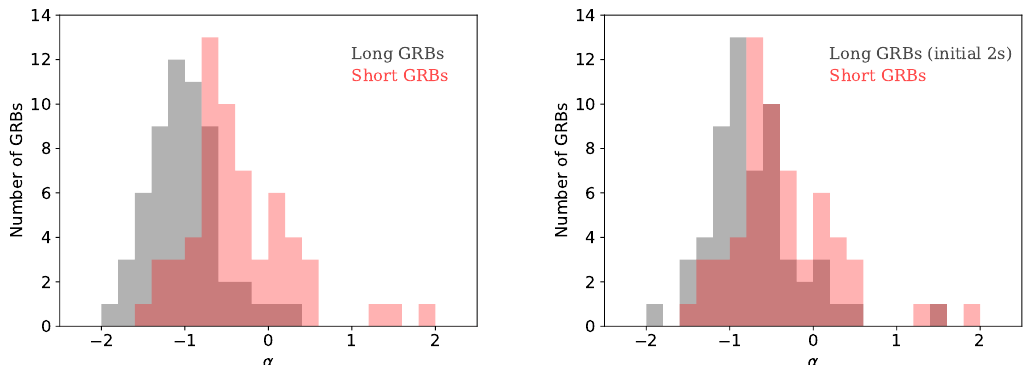
Figure 4. Histograms of α between short GRBs and long GRBs ( left ), and short GRBs and the initial 2 s of long GRBs ( right